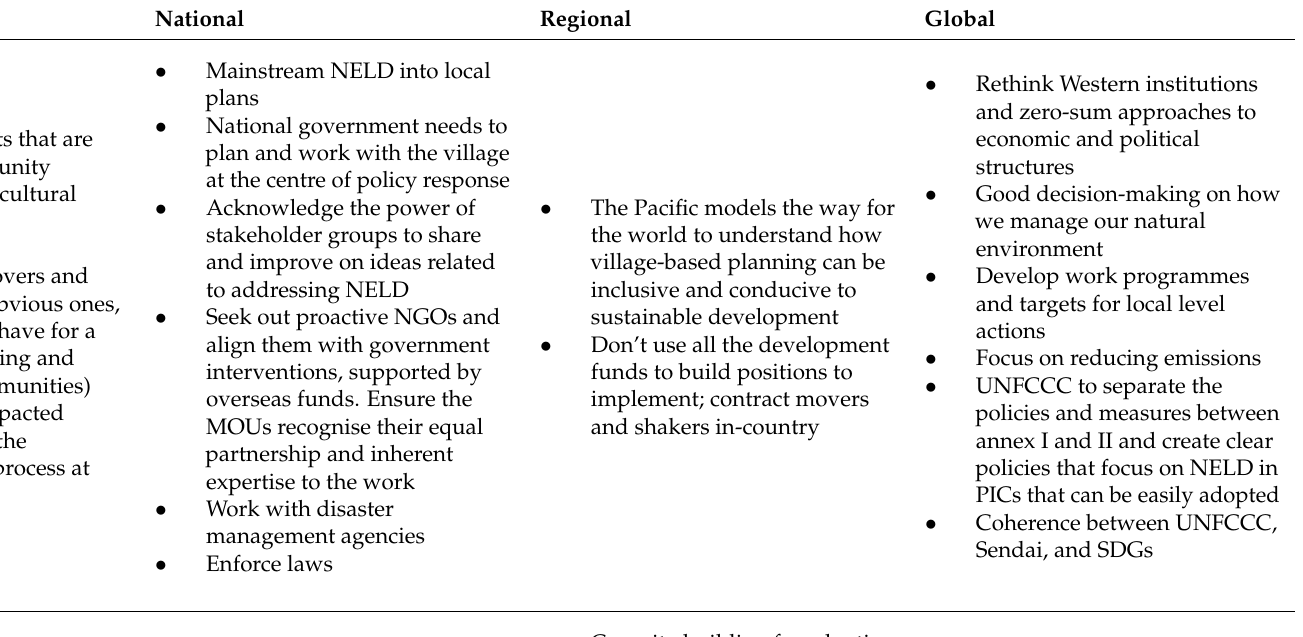
Table 2. Ways the Pacific region can identify and adequately respond to NELD at different